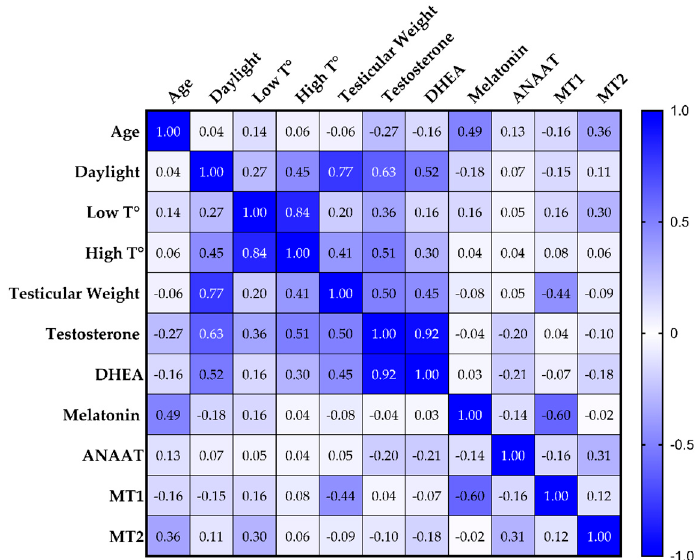
Figure 4. Color-coded Spearman’s rank correlation coefficients ( ρ ) table. Blue background indicates perfect correlations, white shows that the two variables do not vary together; light blue gradients indicate different levels of correlation. DHEA, dehydroepiandrosterone; T ◦ , temperature; AANAT, aralkylamine-N-acetyltransferase; MT1 and MT2, melatonin receptors 1 and 2.